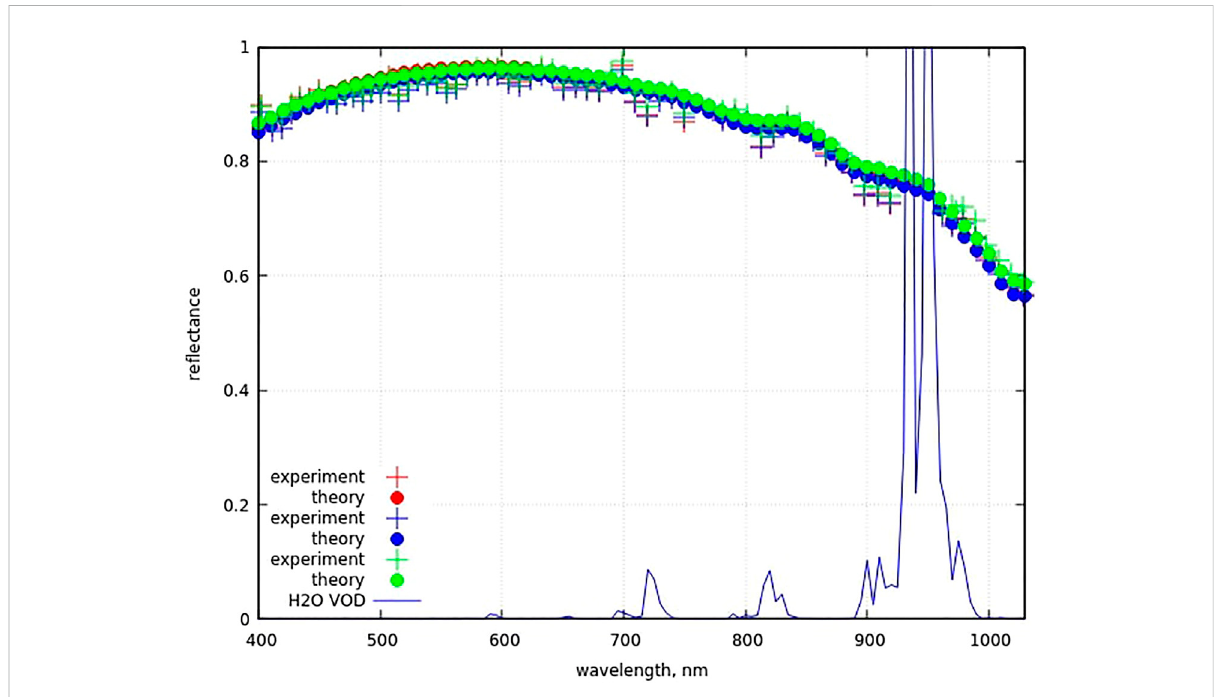
FIGURE 3 Comparison of theory and satellite measurements for the last cases shown in Table 3. The sequence of data coincides with the sequence of lines in Table 3. We also show the vertical optical density of water vapor at the assumption that the vertical water vapor column is 1.301 × 10 22 molecules cm 2 ( courtesyof L . Lelli )